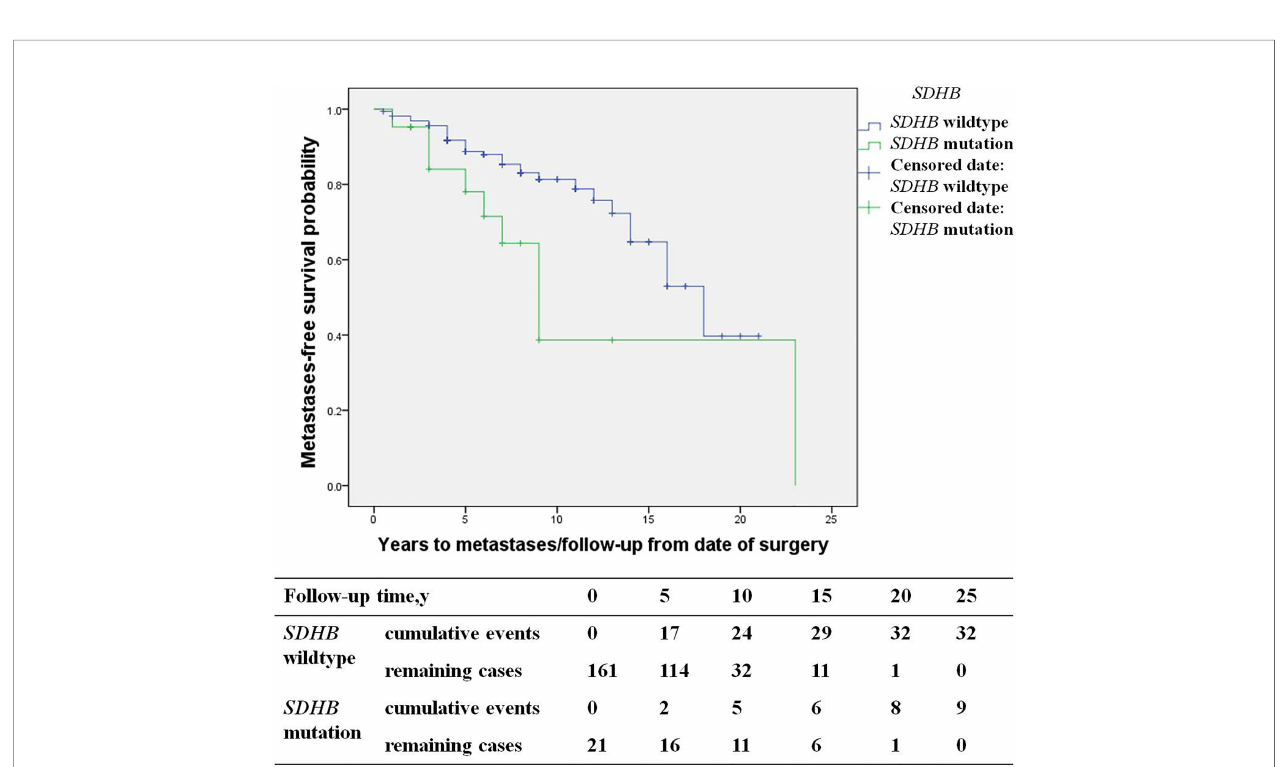
FIGURE 5 | Progression-free metastases ( SDHB mutation patients versus SDHB wildtype patients) in PPGL